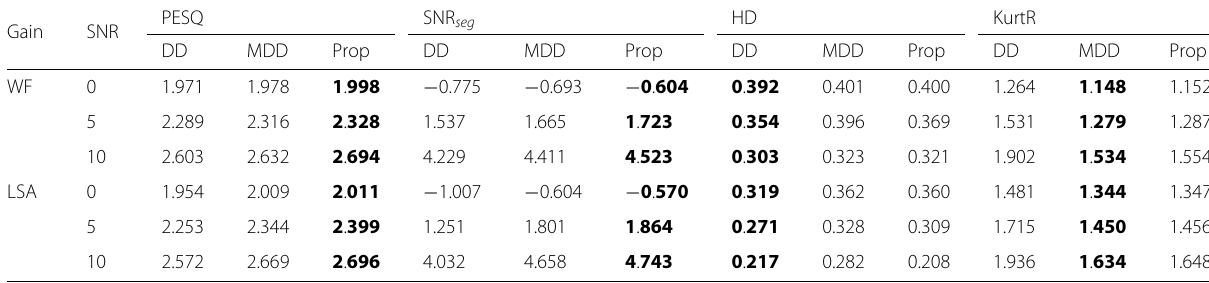
Table 10 Mean objective results for babble noise